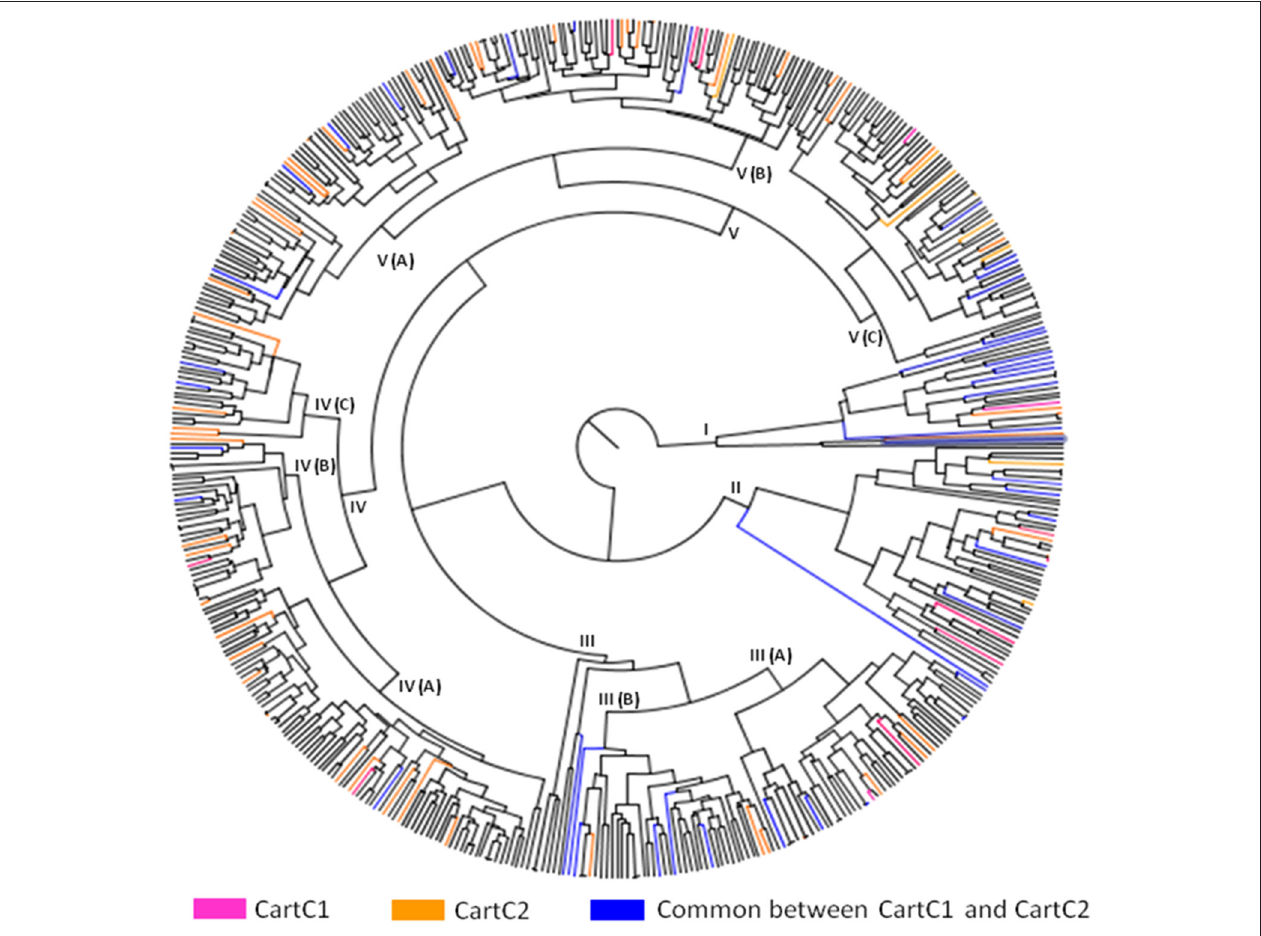
FIGURE 5 | Distribution of accessions of composite core collections (CartC1 and CartC2) in different clusters of UPGMA dendrogram (morphological data). Accessions unique to CartC1 and CartC2 are represented by pink and orange color, respectively. Accessions common between these two collections are represented by